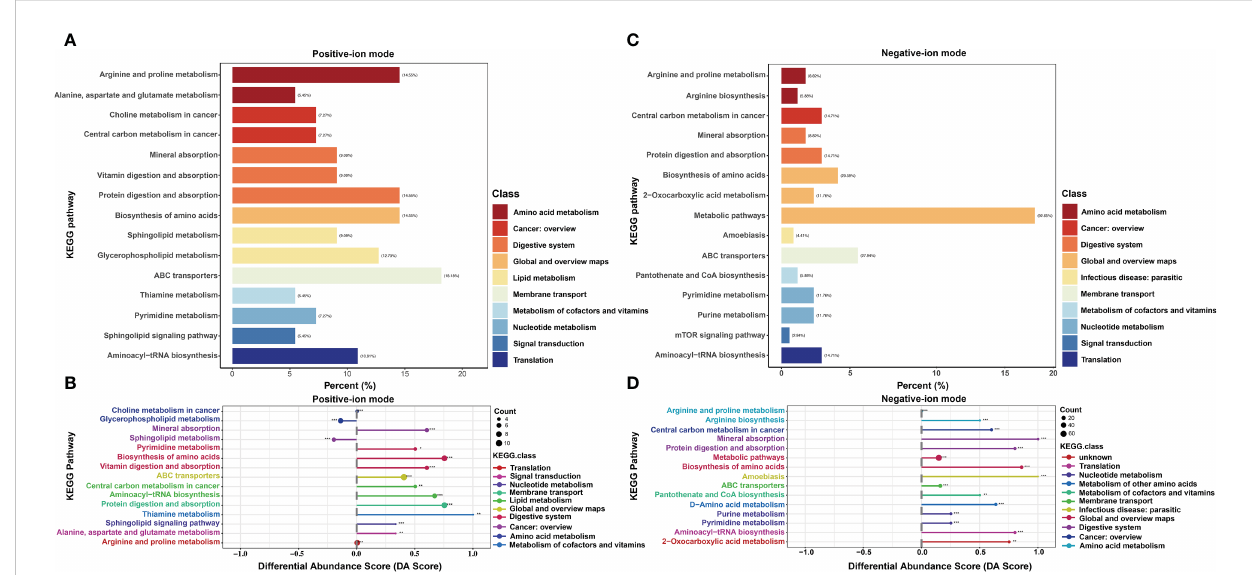
FIGURE 3 KEGG enrichment analysis of differential metabolites (DMs) between HUVECs and HemECs by nontargeted metabolic analysis. (A, C) Enrichment analysis of DMs. (B, D) , Differential abundance score analysis of DMs. Each dot represents a metabolic pathway. The X-axis is the differential abundance (DA) score, and the Y-axis is the ID number of the KEGG metabolic pathway. * represents signi fi cance. * P < 0.05, ** P < 0.01, *** P <